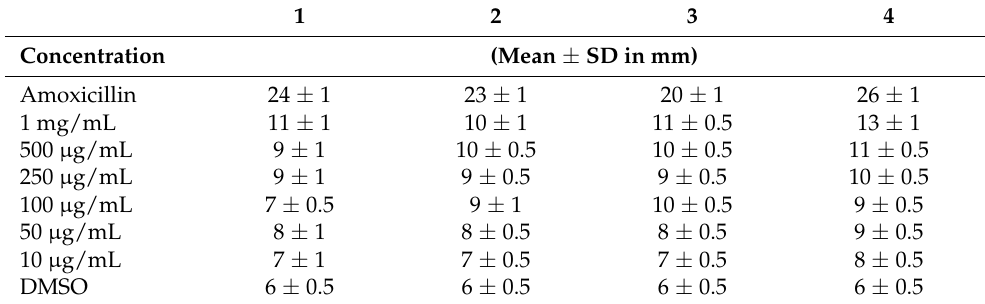
Table 2. Antibacterial activity of four compounds isolated from B. subtilis strain EP1 against E. coli . 1 2 3 4 Concentration (Mean ± SD in mm) Amoxicillin 24 ±